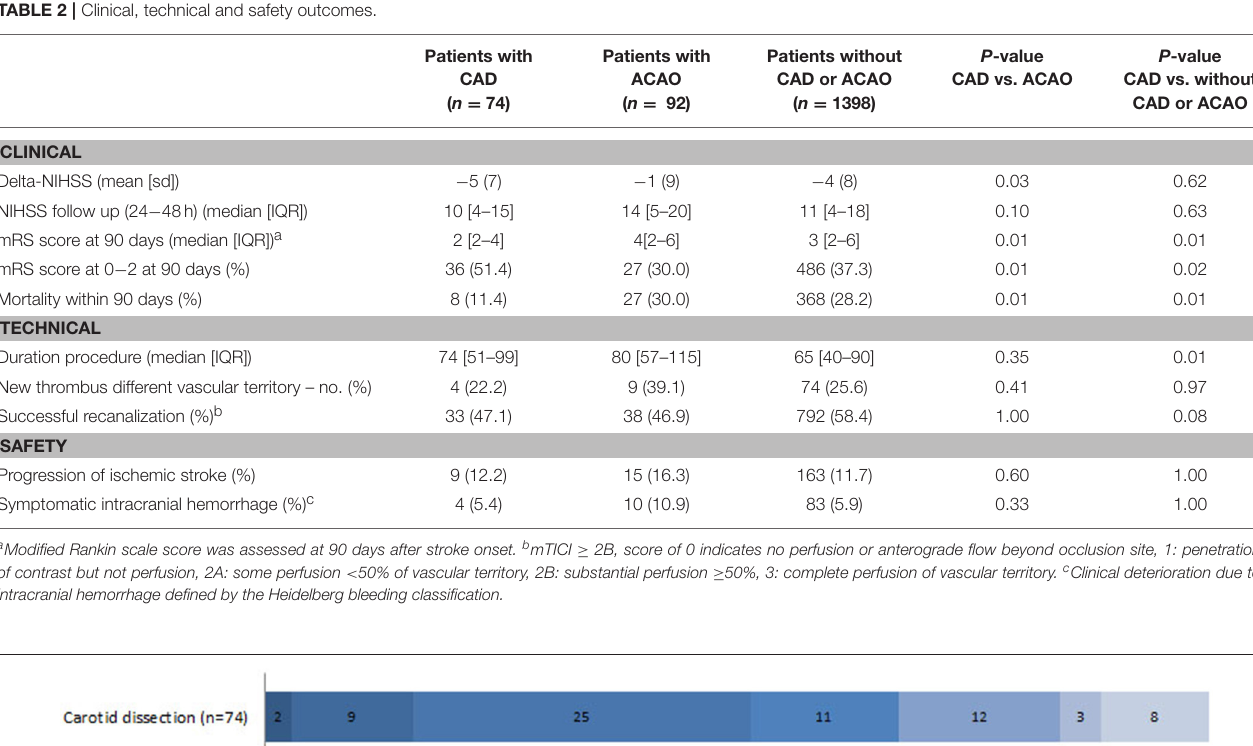
TABLE 2 | Clinical, technical and safety outcomes.